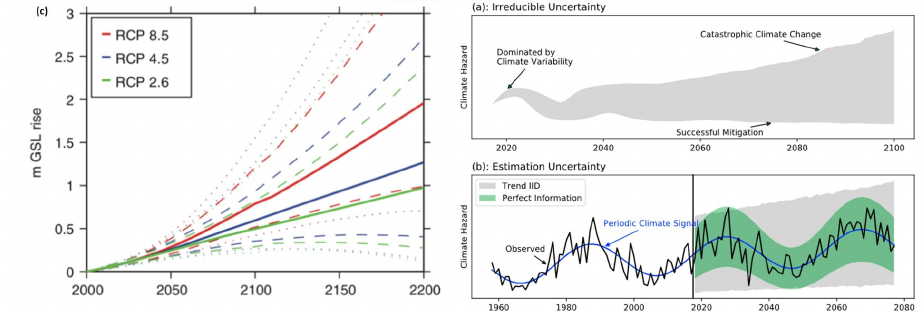
Figure 1. Uncertainties in climate projection due to ( a ) future CO 2 emission scenarios; [18] ( b ) uncer- tainties in climate modelling; ( c ) long period natural cycle